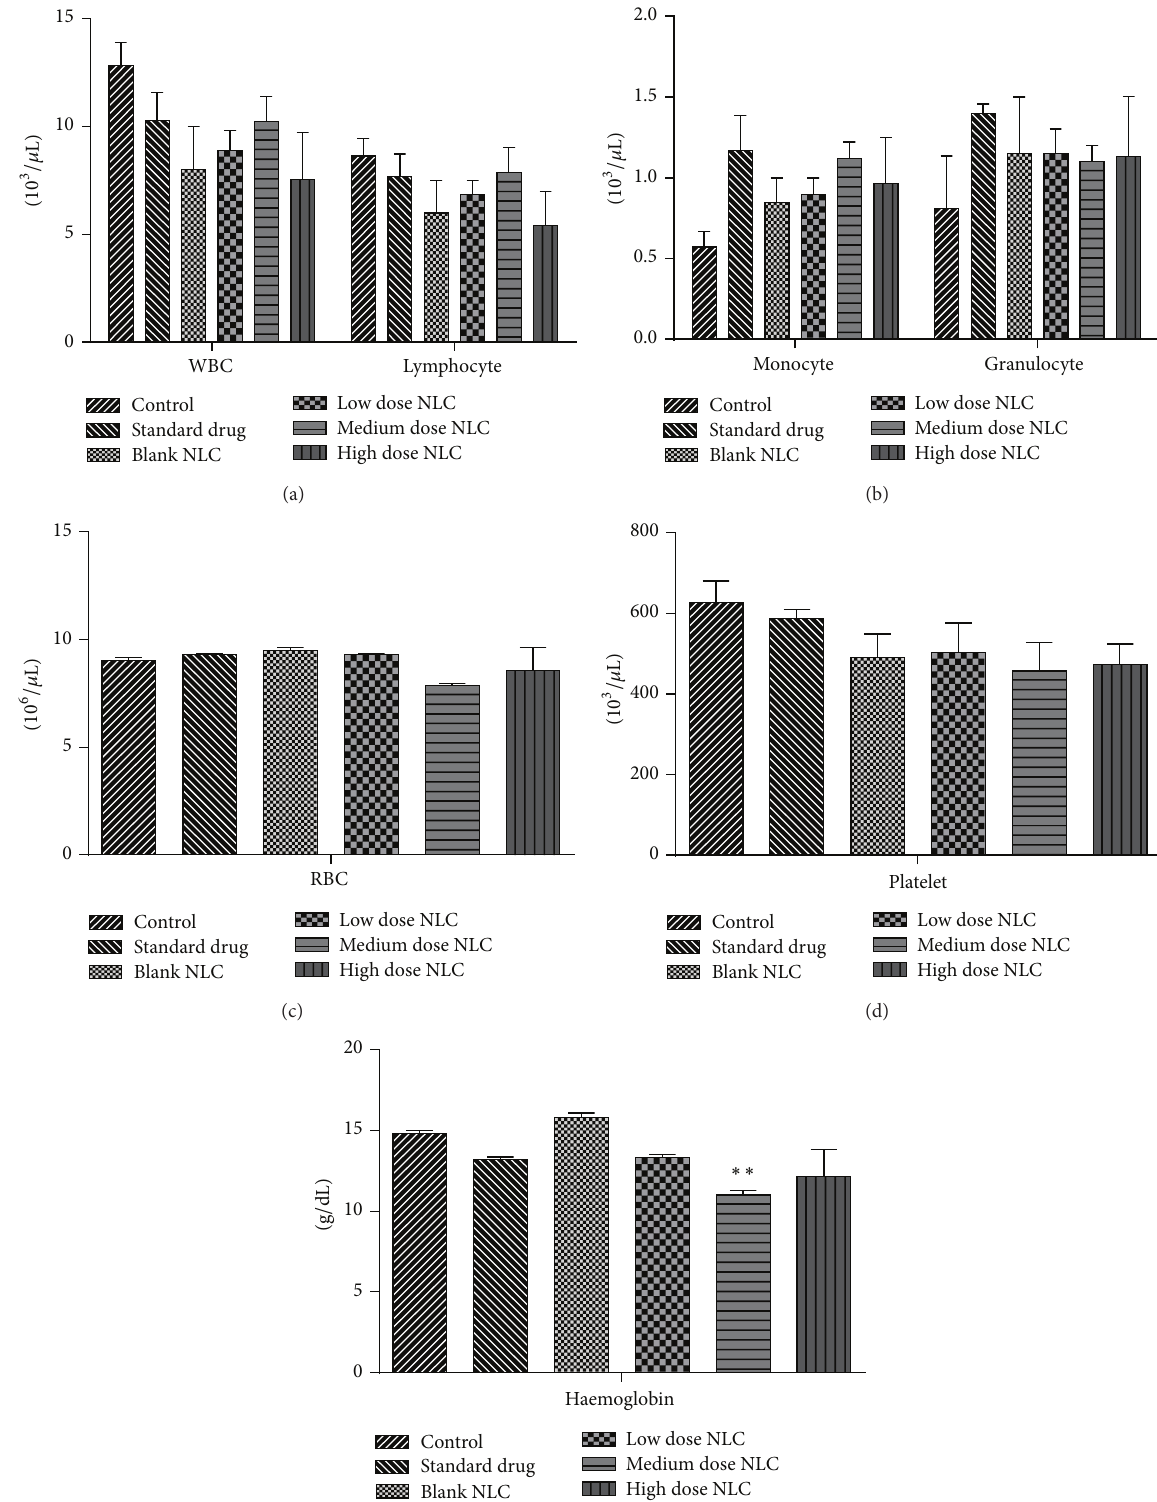
Figure 4: (a, b, c, d, and e) Hematological count of male rats treated with NLCs formulation. All the values are represented as mean ± SEM and 𝑛 = 5 . ∗∗ 𝑝 < 0.01